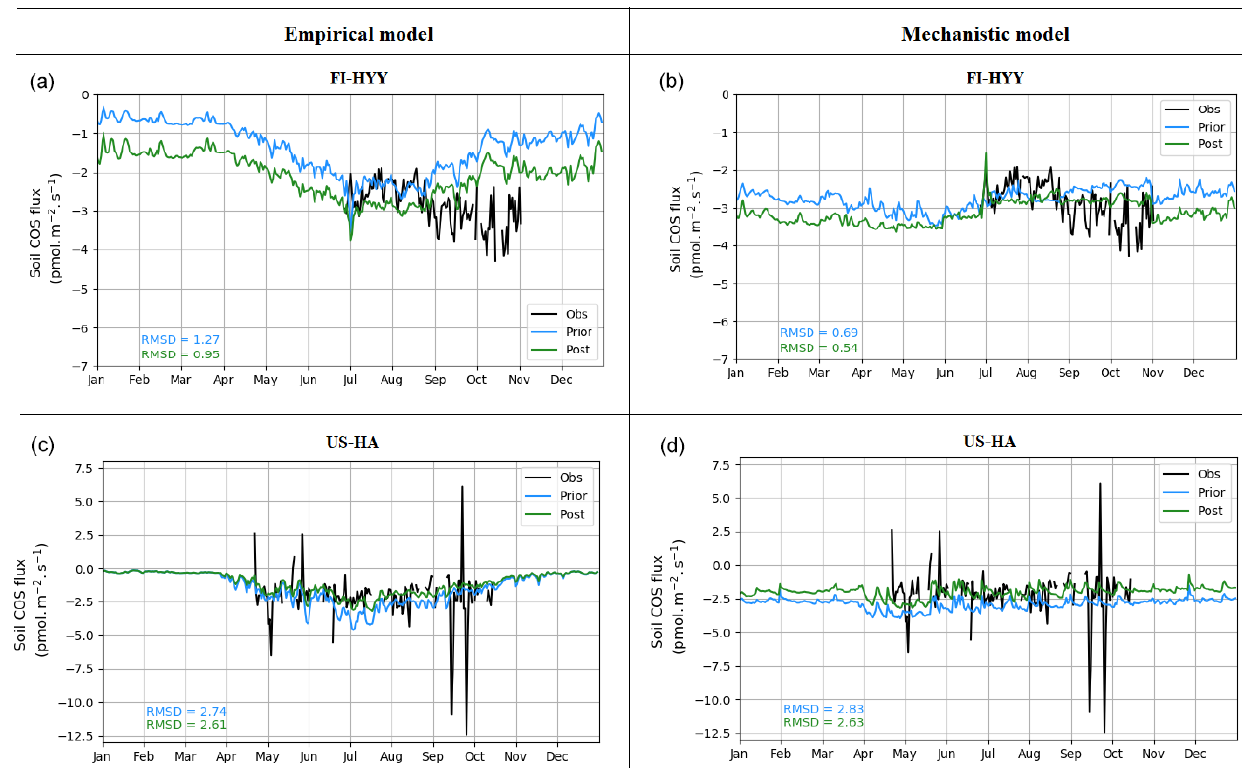
Figure 6. Prior and post-optimization net soil COS fluxes (pmolm − 2 s − 1 ) for the empirical (a, c) and the mechanistic (b, d) models. The two studied sites are FI-HYY (a, b) in 2015 and US-HA (c, d) in